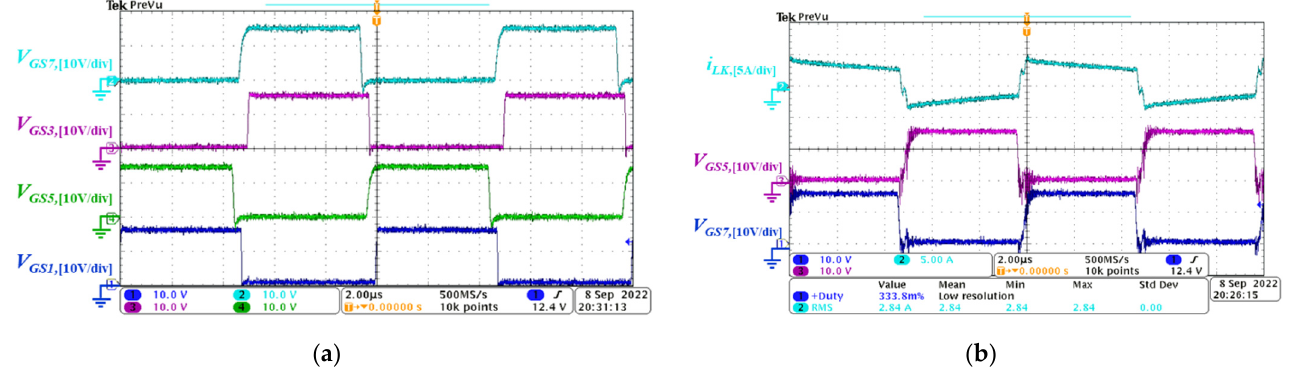
Figure 19. Experimental waveforms of the prototype converter operating in backward power con- version mode (at 1 kW output power): ( a ) waveforms of gate signals V GS1 , V GS3 , V GS5 and V GS7 ; ( b ) waveforms of gate signals V GS5 , V GS7 and inductor current i LK